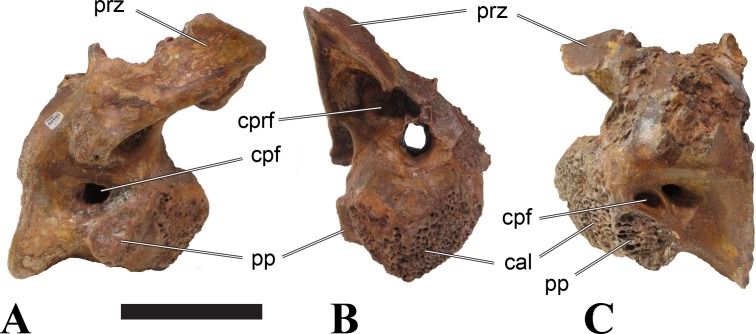
CMN 50792, posterior cervical vertebra of an indeterminate carcharodontosaurid.(A) right lateral view; (B) anterior view; (C) left lateral view. Abbreviations: cal, camellate pneumatic structure; cpf, central pneumatic foramen; cprf, centroprezygapophyseal fossa; pp, parapophysis; prz, prezygapophysis. Scale bar equals 10 cm.